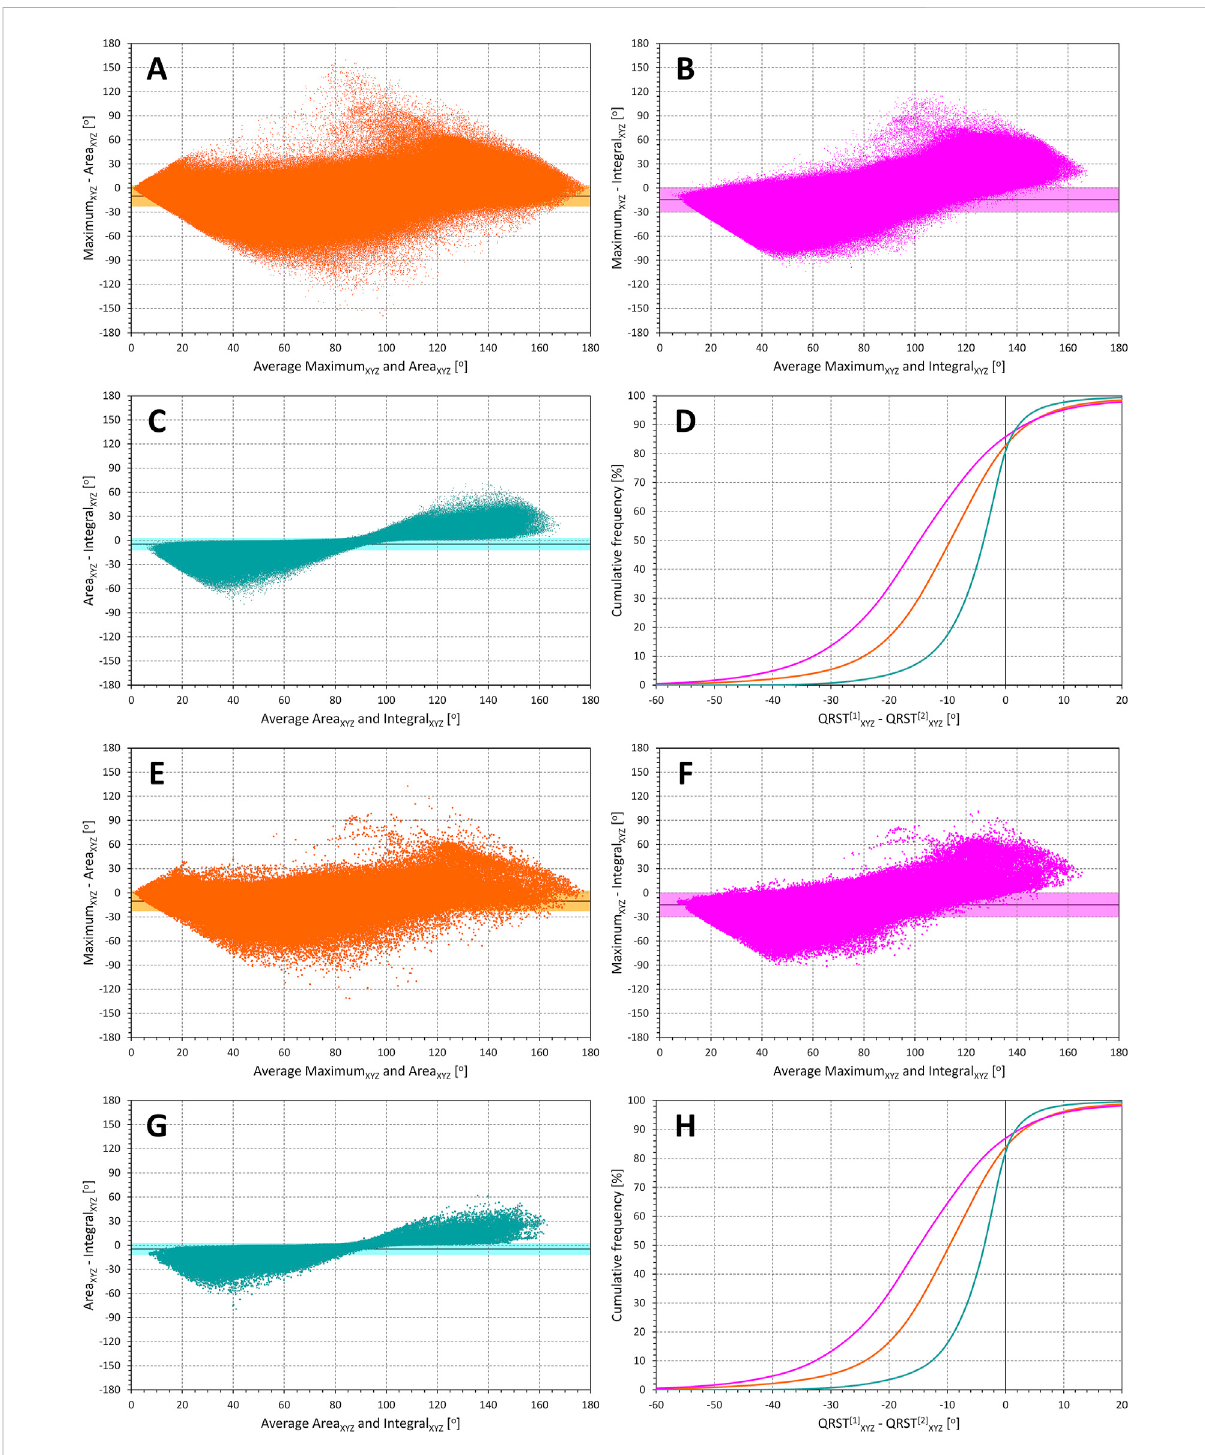
FIGURE 3 Comparisons of methods of QRS-T angle measurements in XYZ orthogonal projections. Bland-Altman type of comparisons between different QRS-Tanglemethodsappliedtothematrix-derivedorthogonalleadsXYZ.Thelayoutofthe fi gureandoftheindividualpanelscorrespondstothatof Figure1,withallthemeasurementsinallstudysubjectspooled.Panels (A – C) showsthecomparisonsofMaximum XYZ withArea XYZ ,Maximum XYZ with Integreal XYZ , and Area XYZ with Integral XYZ , respectively, all values are derived from individual beat measurements. Panel (D) shows corresponding cumulative distributions, i.e., of pooled values Maximum XYZ ─ Area XYZ , Maximum XYZ ─ Integreal XYZ , and Area XYZ ─ Integral XYZ . Panels (E – H) show the same analysis applied to the measurements derived from representative median waveforms of 10-s ECG segments (again pooled over all study